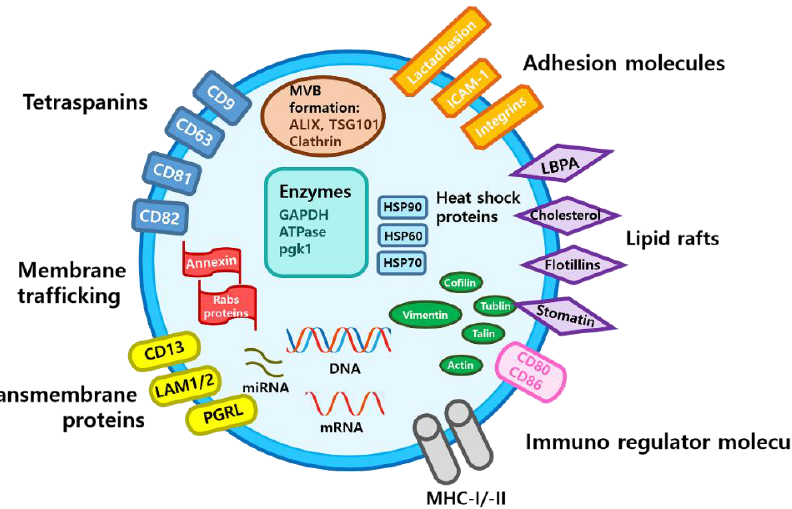
Figure 1. Schematic structure and contents of exosome. ATPase, adenosine triphosphatase; CD, cluster of differentiation; GAPDH, glyceraldehyde 3-phosphate dehydrogenase; HSP, heat shock protein; ICAM-1, intercellular adhesion molecule-1; LAM 1/2, lysosomal-associated membrane protein 1/2; MHC, major histocompatibility complex; miRNA, microRNA; mRNA, messenger RNA; MVB, multivesicular body; PGRL, PG regulatory-like protein; pgk1, phosphoglycerate kinase 1.